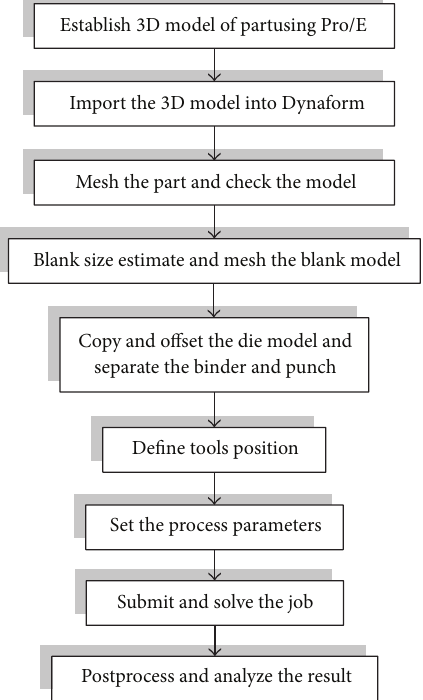
Figure 1: Flowchart of the process simulation.